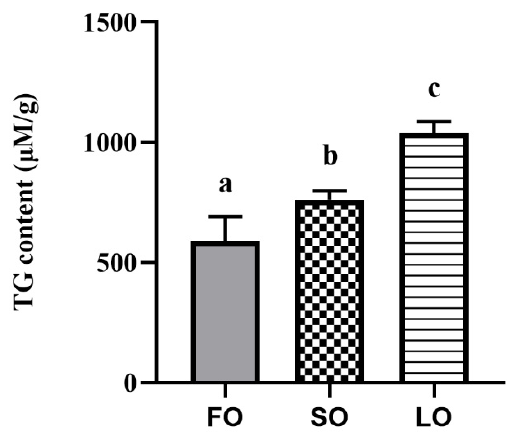
Figure 1. Effects of dietary SO and LO on triglyceride (TG) contents in adipose tissue of large yellow croaker. Results were presented as the means ± S.E.M. and were analyzed using Tukey’s test (n = 4). Bars labeled with the same letters are not significantly different ( p > 0.05). FO, fish oil; SO, soybean oil; LO, linseed oil.